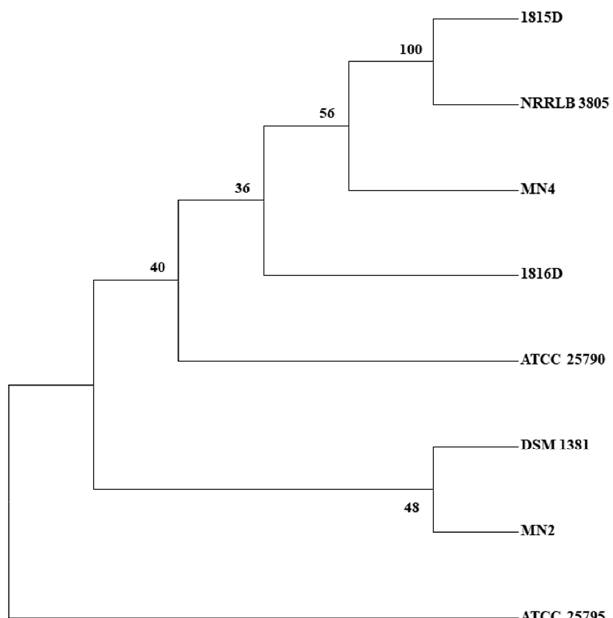
Figure 2. Consensus parsimonious tree derived from SNPs detected in eight strains of M. neoaurum. DSM 1381, M. neoaurum DSM 1381; ATCC 25790, M. neoaurum ATCC 25790; ATCC 25795, M. neoaurum ATCC 25795; VKM Ac 1815D, Mycobacterium sp. VKM Ac 1815D; VKM Ac 1816D, Mycobacterium sp. VKM Ac 1816D; MN2, M. neoaurum MN2; MN4, M. neoaurum MN4; NRRLB 3805, M. neoaurum NRRLB 3805.